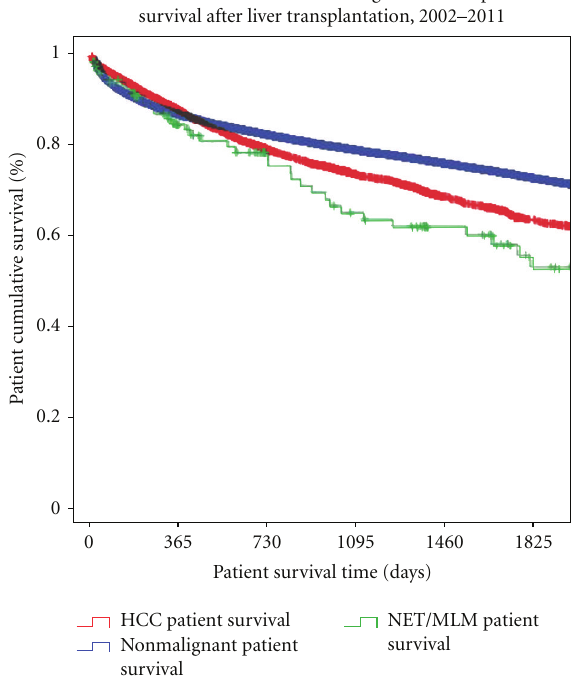
Figure 5: NET/NLM versus HCC versus nonmalignant patient sur- vivals after transplantation, 2002–2011. NET/NLM versus HCC ( P = 0 . 109); NET/NLM versus nonmalignant ( P = 0 . 002).